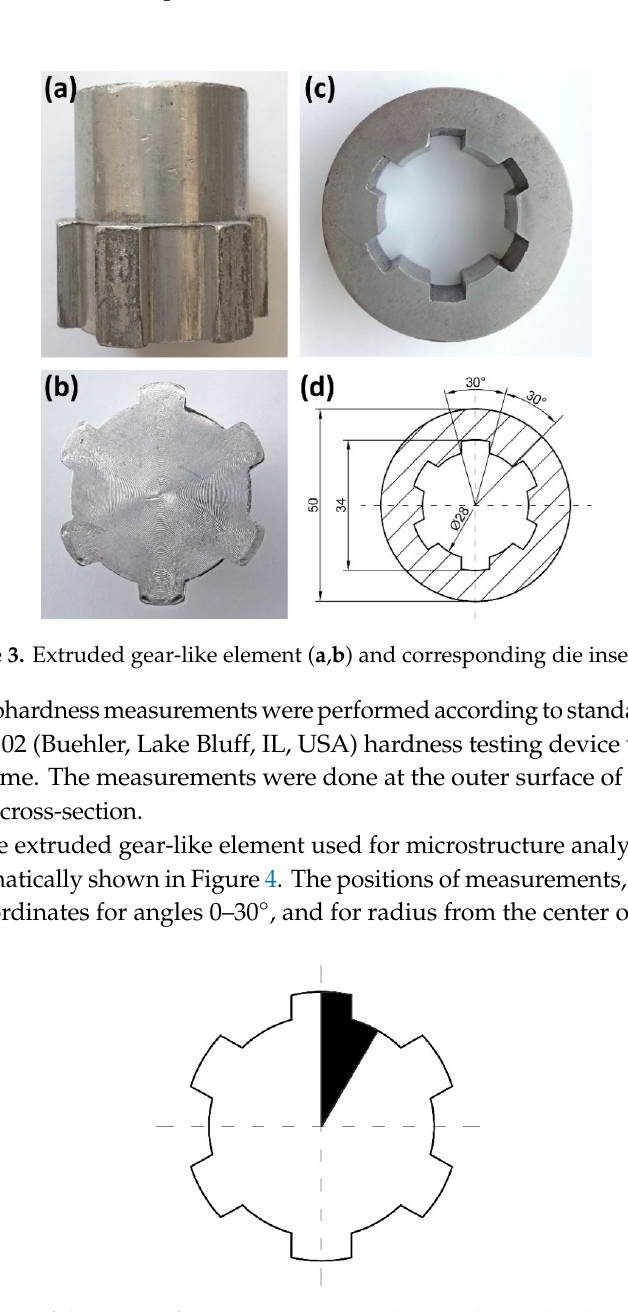
Figure 4. Scheme of the section for microstructure analysis and microhardness measurement.